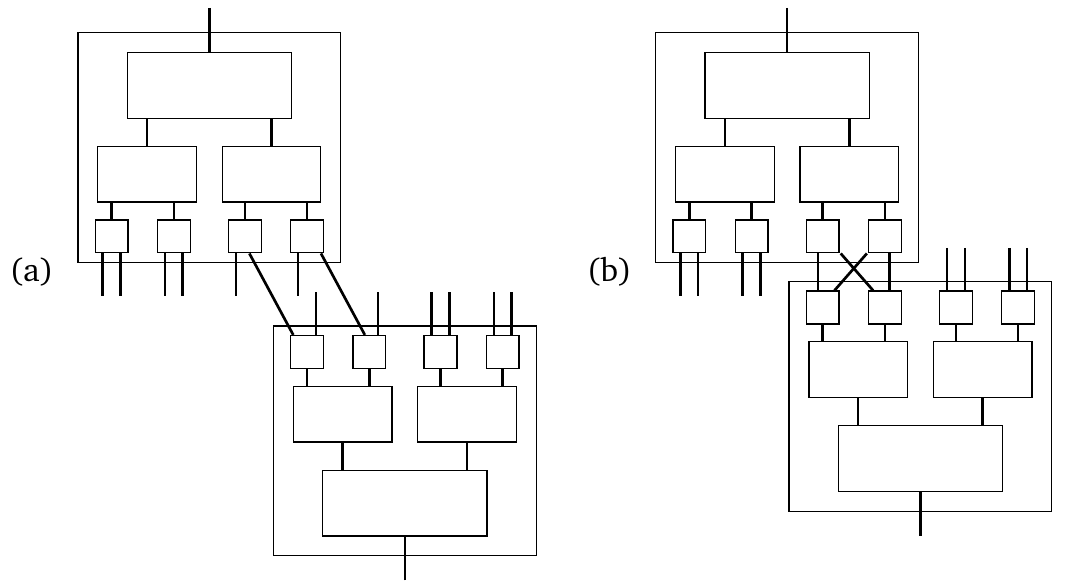
Figure 8: Two examples of misaligned trees are shown. Importantly there is no contraction sequence which avoids creating intermediate tensors of rank larger than that with which the components of the tree